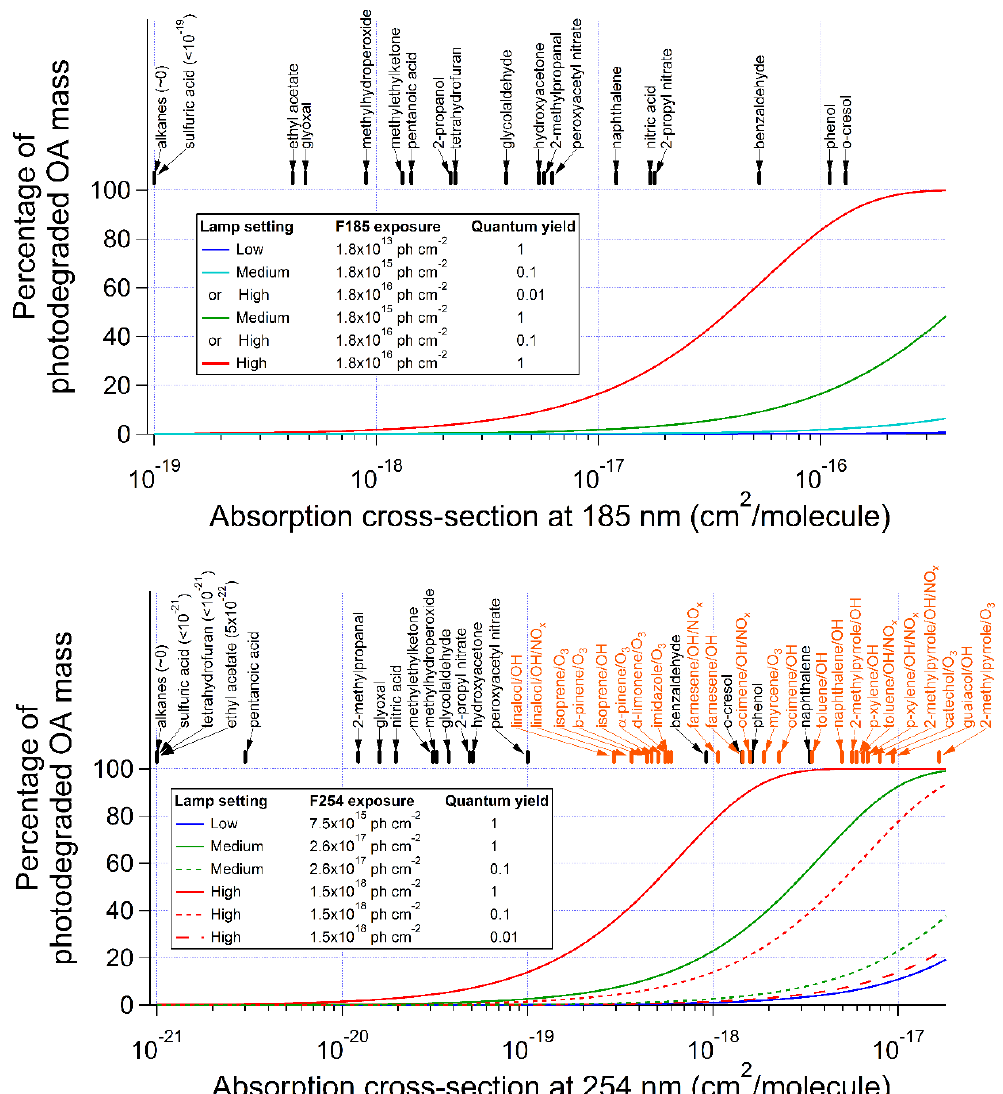
Figure 8. Percentage of SOA photodegradation at (upper panel) 185 and (lower panel) 254nm at different UV levels as a function of absorption cross section under the assumptions of quantum yields of 1, 0.1, and 0.01. Absorption cross sections of some SOA component surrogates (black tag) and SOA samples (orange tag; calculated from data in Lambe et al., 2013, and Romonosky et al., 2016) are also